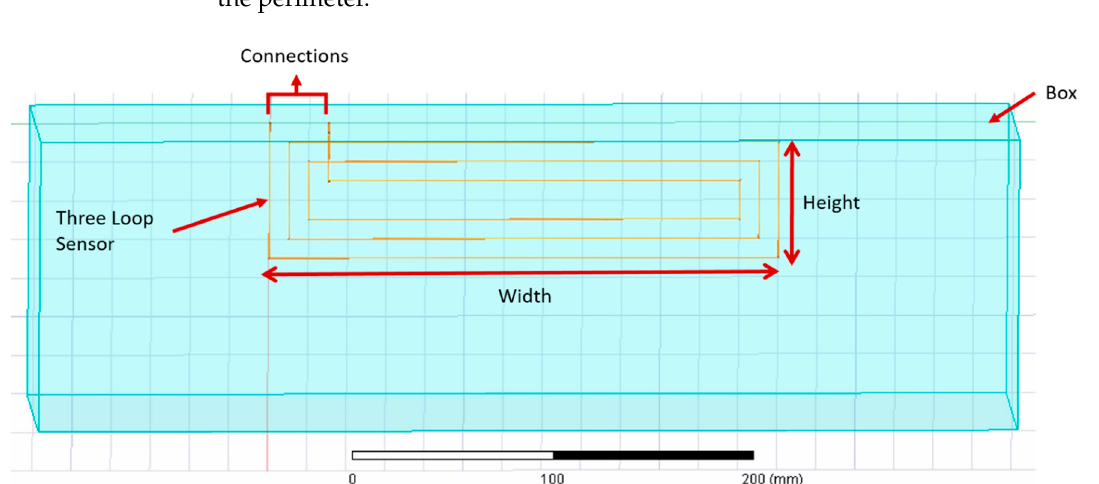
Table 9. Inductance calculation of a single loop rectangle with a constant area (15,600 mm 2 ) using Ansys simulations and Equation (1).